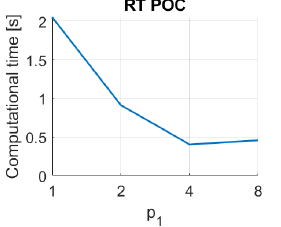
Figure 19. RT–POC image retrieval problem. Computational